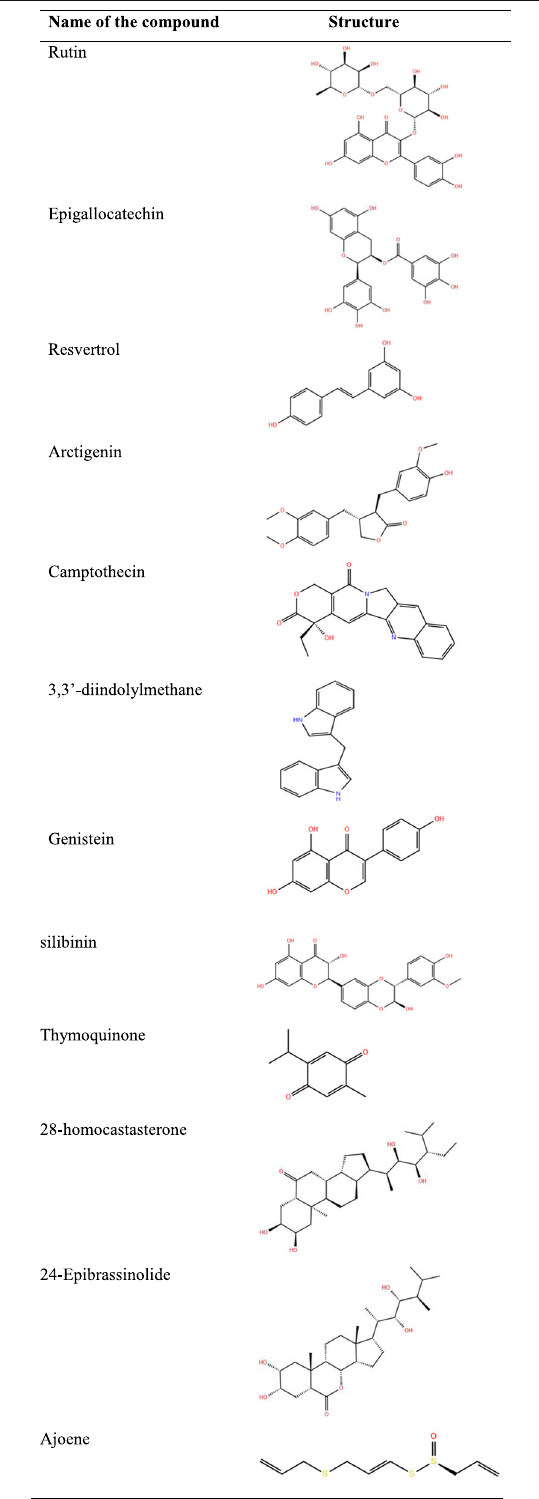
Table 2 Name of natural bioactive compounds and their